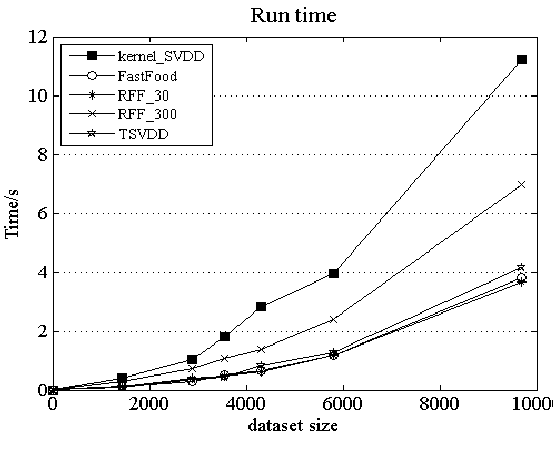
Figure 6. Comparison of run time.